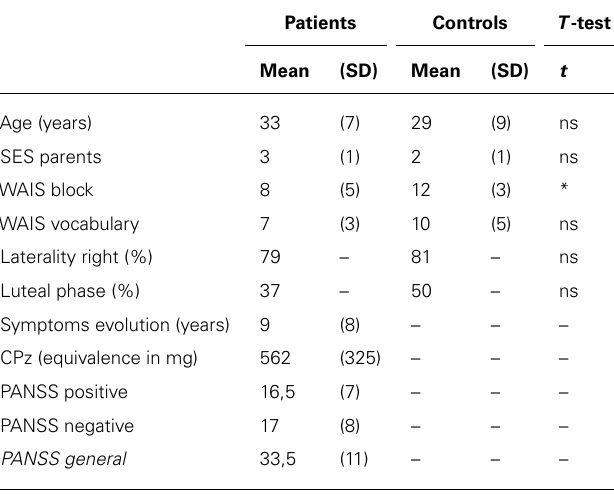
Table 1 | Comparison of means and standard deviations (parentheses) of clinical and demographic